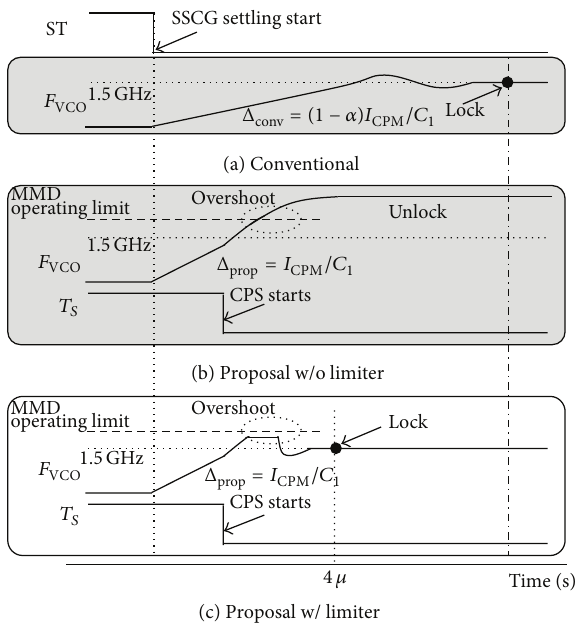
Figure 8: Explanation of proposed fast-lock dual-CP SSCG settling operation of the conventional SSCG (a) and the proposed dual-CP controlled technique without VCO high frequency limiter (b) and with limiter (c).